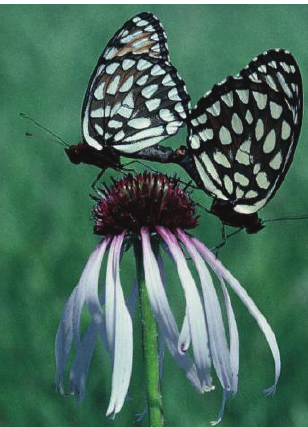
Figure 2: Ventral view of Regal Fritillaries mating while perched on Pale Purple Coneflower ( Echinacea pallida ) in Missouri, USA, with female on right (larger and darker in the forewing tip than the male). Photo by Ann B.